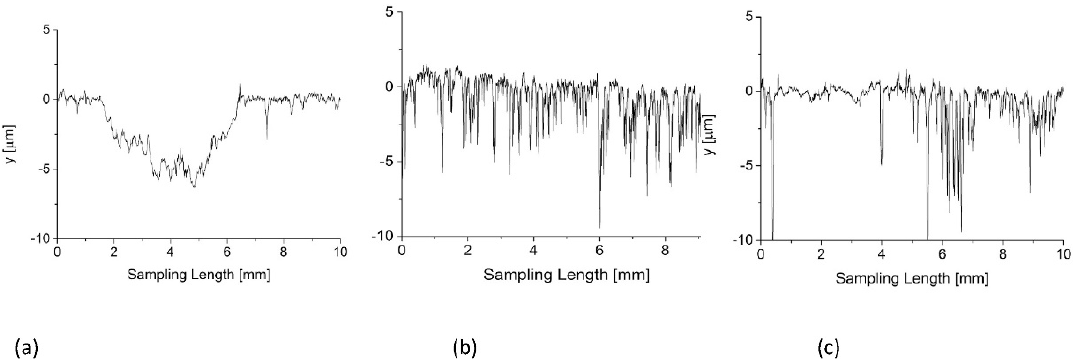
Figure 6. Surface wear track profiles after pin-on-disc tests at room temperature of; ( a ) GCI disc; ( b ) WC-10Co-4Cr coated disc; and ( c ) 75Cr 3 C 2 -25NiCr coated disc [118]. Reprinted with permission from [118]. © 2017 Elsevier.